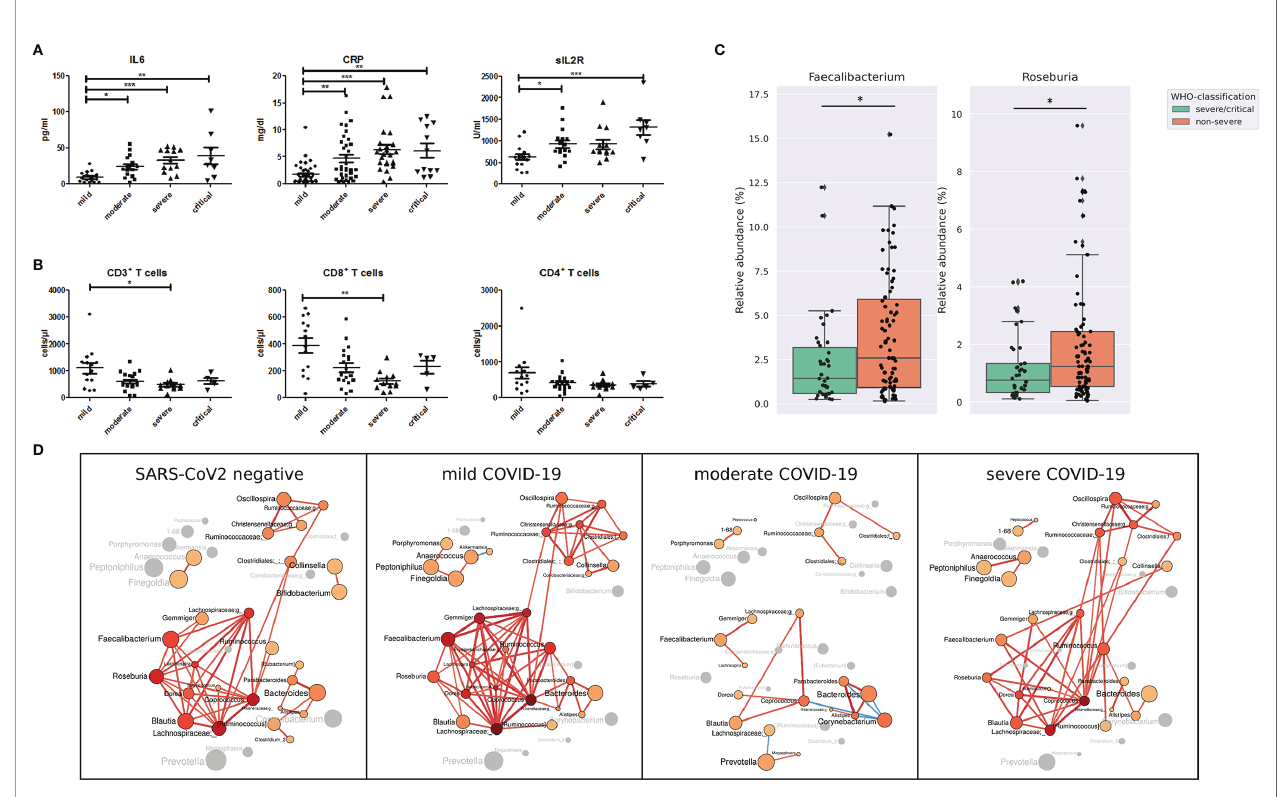
FIGURE 2 | (A) Serum levels of pro-in fl ammatory markers interleukin 6 (IL-6), C-reactive protein (CRP) and soluble IL-2 receptor (sIL2R) and (B) total number of CD3 + T cells, CD8 + T cells and CD4 + T cells in COVID-19 patients according to disease severity. *P<.05; **P<.01¸***P<.001 (C) Relative abundance of bacterial genera Faecalibacterium and Roseburia in patients with non-severe and severe/critical COVID-19 according to the WHO classi fi cation. *P<.05 (D) Gut microbiota co-occurrence networks are visualized for SARS-CoV-2 negative patients, patients with mild, moderate and severe COVID-19 severity illness. Nodes represent bacterial genera. The size of each node indicates the average relative abundance of the genus in the corresponding group and each node is colored based on the degree of the node (number of edges). Labels are scaled with the size of the nodes. The intensity of the red color of the nodes increases according to the number of the genera ’ s edges. Genera without a signi fi cant co-occurrence are colored in gray in the group that lacks a co-occurrence partner. The width of the edges are weighted based on the absolute value of the co-occurrences and colored red for positive and blue for negative